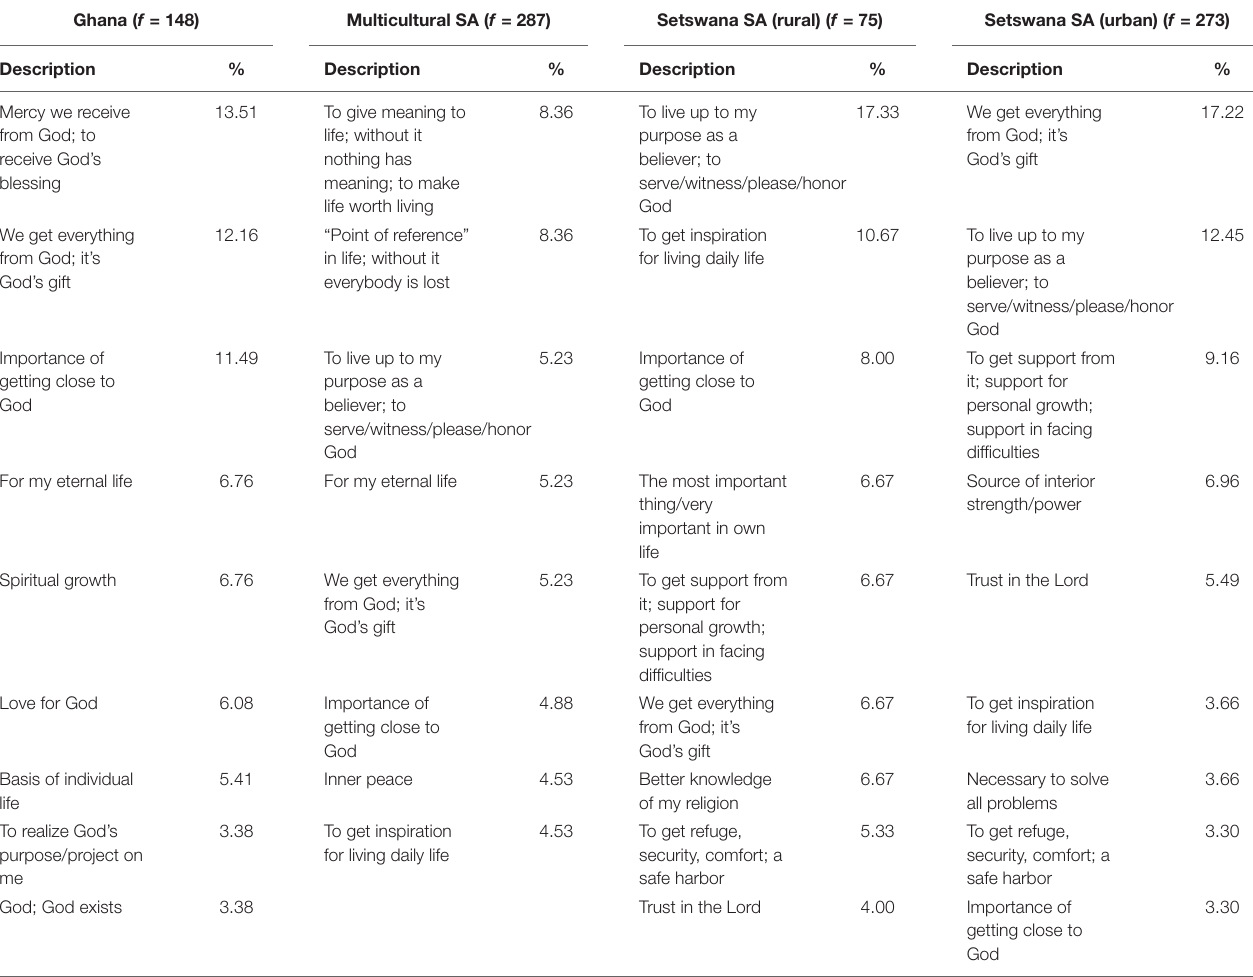
TABLE 8 | Percentages of the most frequent codes in the motivations for meaning sources in the spirituality/religion domain of life. Ghana ( f =